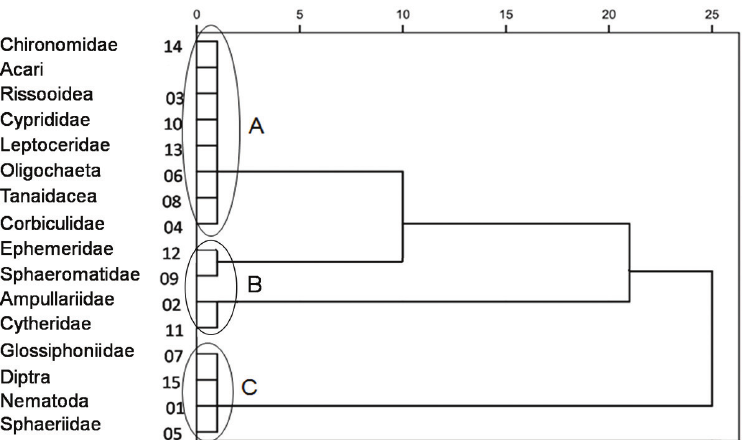
Figure 4. Macroinvertebrate groupings with respect to depth (m) of Lake Figueira, by Cosine’s algorithm: (A) below the euphotic zone depths, (B) within the euphotic zone (C) depths under 3 m.